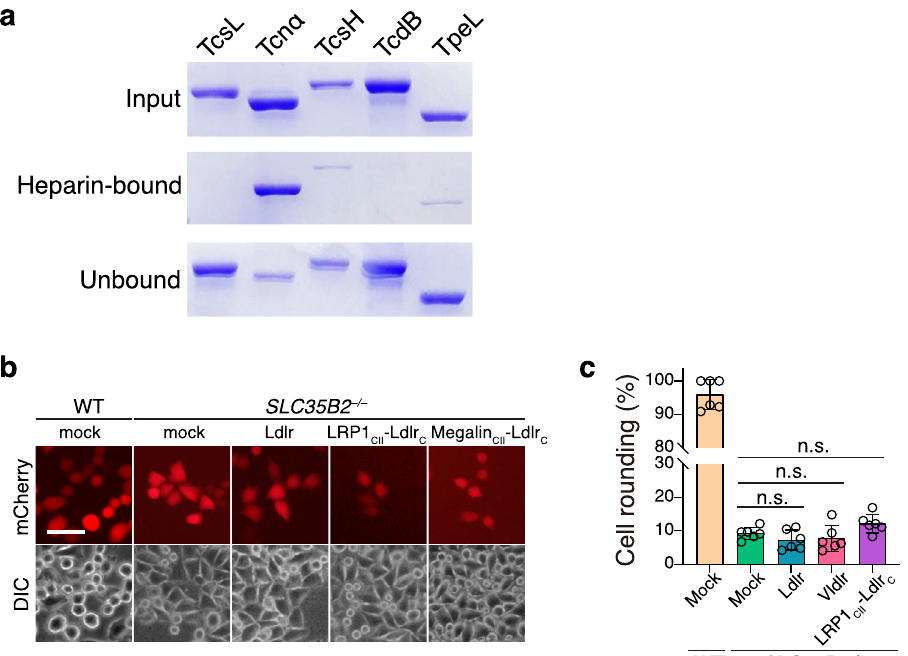
Fig. 3 LRP1- and Megalin-mediated Tcn α uptake require cell-surface sGAG. a TcsL, Tcn α , TcsH, TcdB, and TpeL were incubated with Heparin-Sepharose at 4 °C for 1 h. The protein samples were prepared from the input, toxin-bound heparin beads, and the supernatant was separated on an SDS-PAGE and detected by coomassie blue staining. b The HeLa WT or SLC35B2 ‒ / ‒ cells were transfected with mock, Ldlr, LRP1 CII -Ldlr C, and Megalin CII -Ldlr C . The cells were then incubated with 200 nM Tcn α on ice for 30 min, changed with the fresh medium, and incubated at 37 °C for 3 h. Representative images are shown. Red fl uorescence (mCherry) marked transfected cells. The scale bar represents 50 μ m. c The round-shaped cells among all mCherry-positive cells shown in b were quanti fi ed and plotted in a bar chart. Error bars ( n = 6) indicate mean ± SD, n.s. not signi fi cant, two-sided Student ’ s t